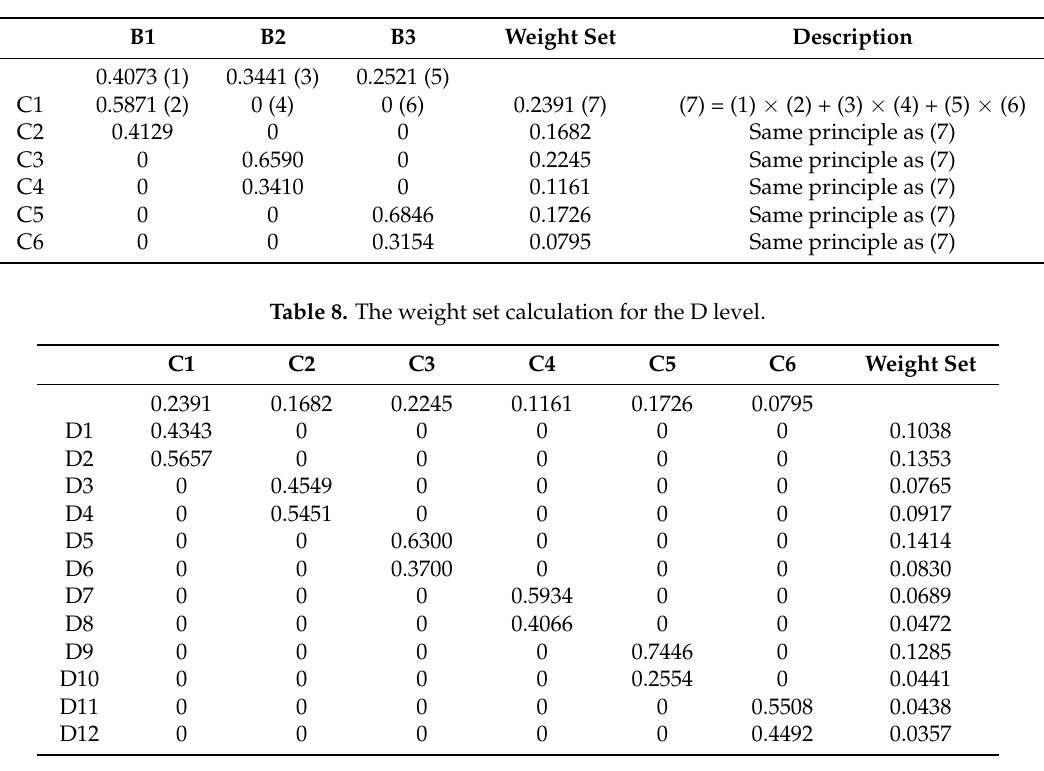
Table 7. The weight set calculation for the C level.